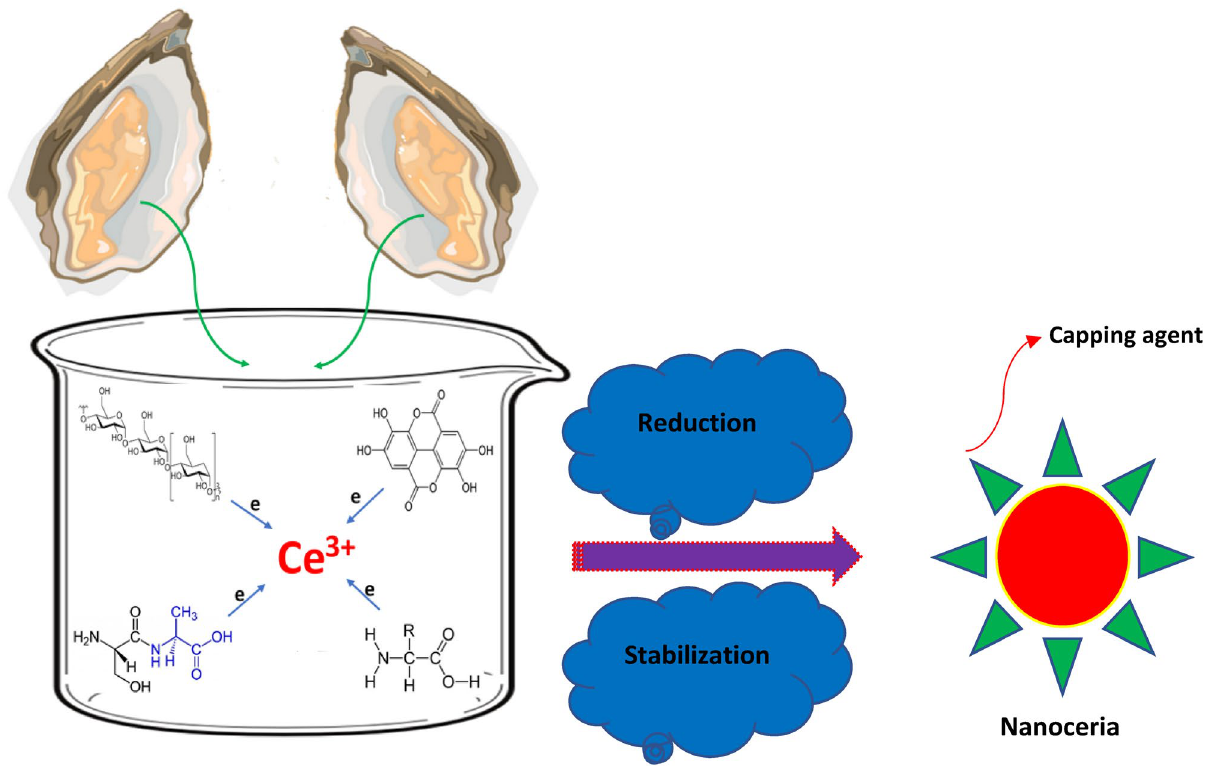
Figure 1. Schematic representation of the biosynthetic pathway of nanoceria using marine oyster